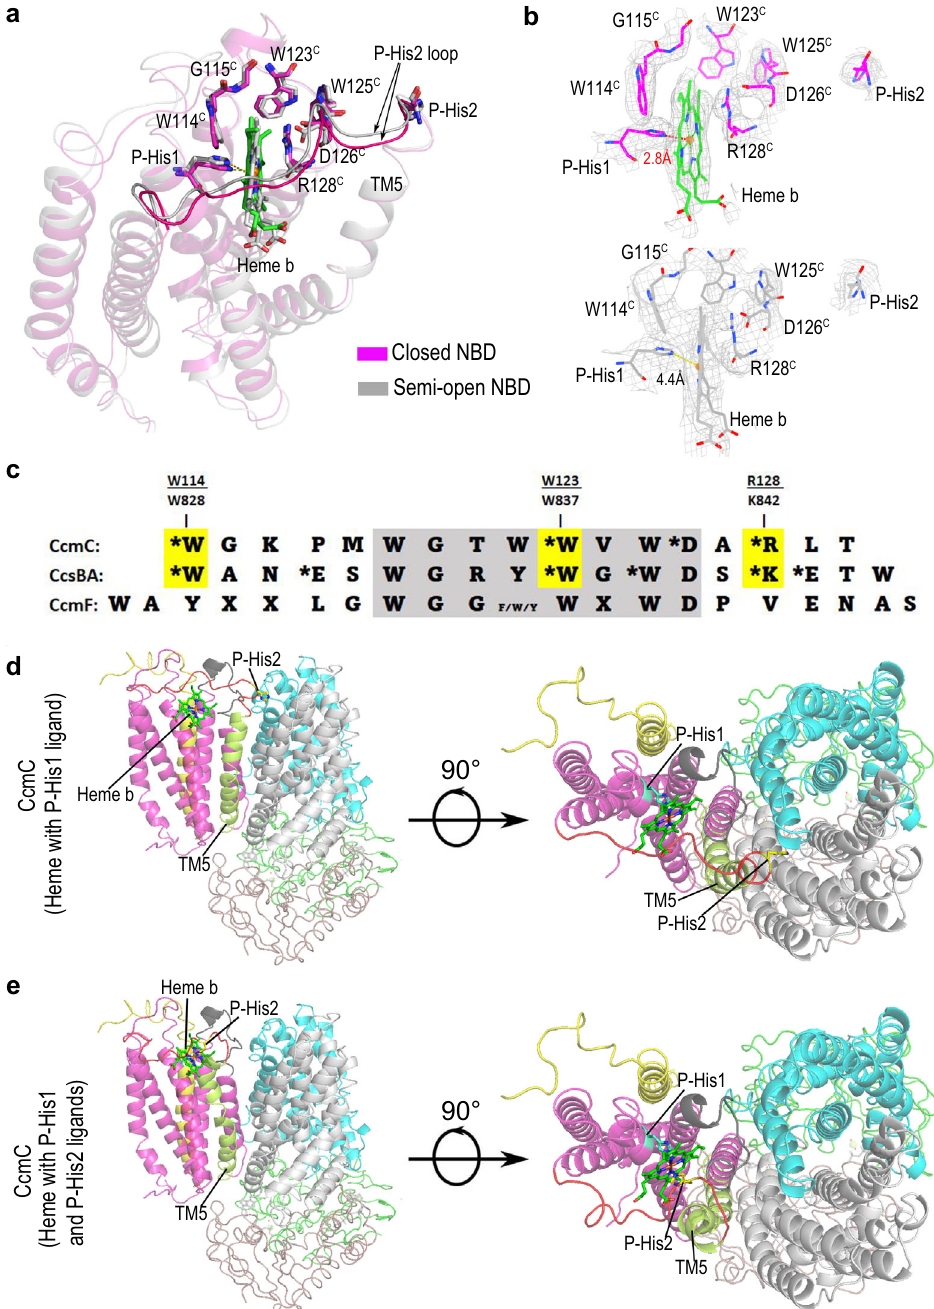
Fig. 2 | Heme-bound structure and heme traf fi cking. a Comparison of heme bindingsitesofclosedNBD(magenta)andsemi-openNBD(gray)conformations.In the closed NBD conformation, P-His1 is liganded to heme. In the semi-open NBD conformation, the distance and angle between the heme and P-His1 indicates that the heme is not liganded. b CryoEM density for bound heme and the surrounding residues in the closed NBD (upper) and semi-open NBD (lower) conformations. c The sequence alignment of the WWD domain of CcmC, CcsBA and CcmF. The